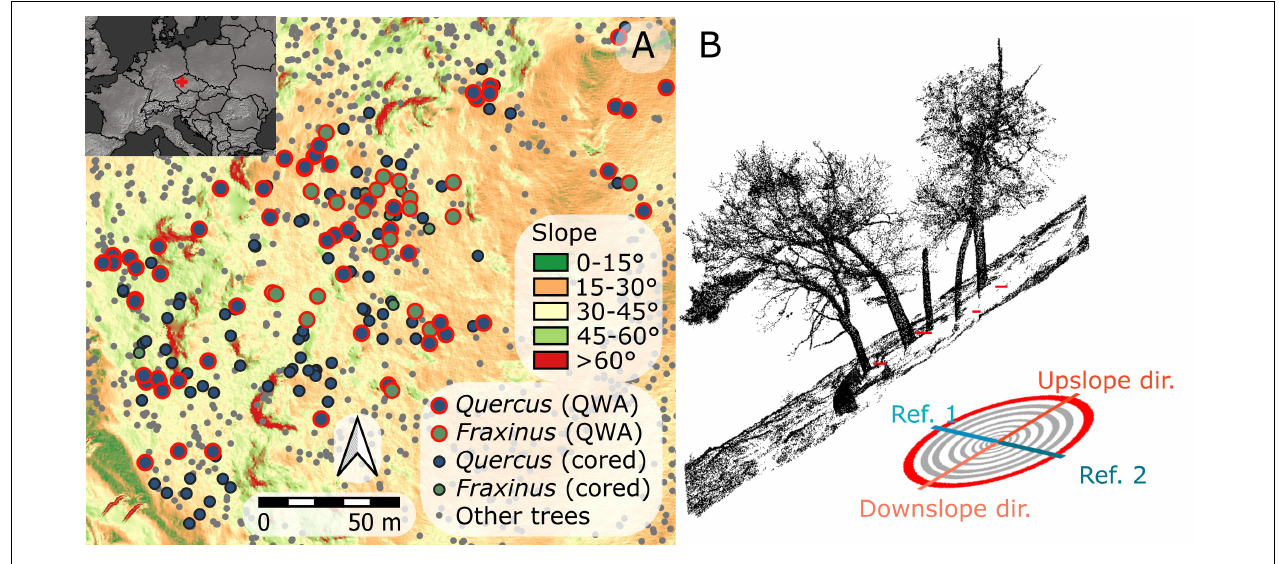
FIGURE 1 | Map of the study site (A) and schematic image of field data sampling (B)